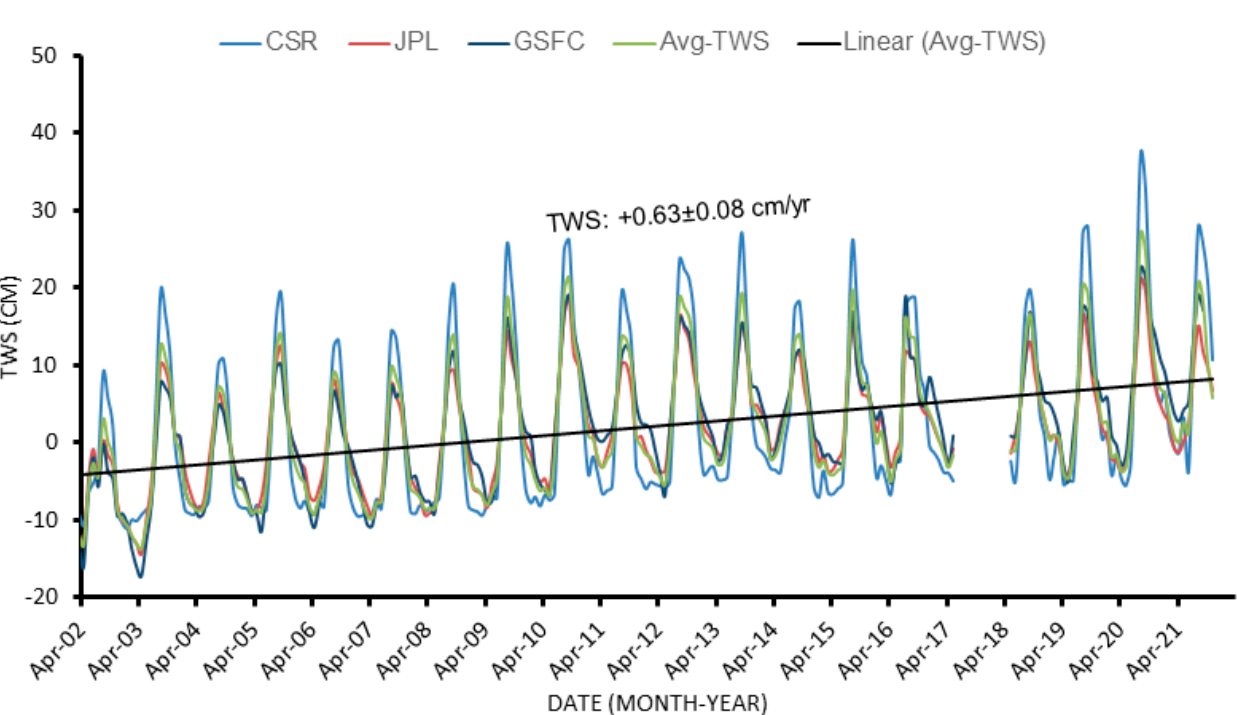
Figure 2. Monthly time series of the ∆ TWS from the different GRACE sources and their averaging (Avg-TWS) over the study area during the entire period. Table 1. GRACE-derived Δ TWS components (cm/yr) over the study area at 95% confidence level.